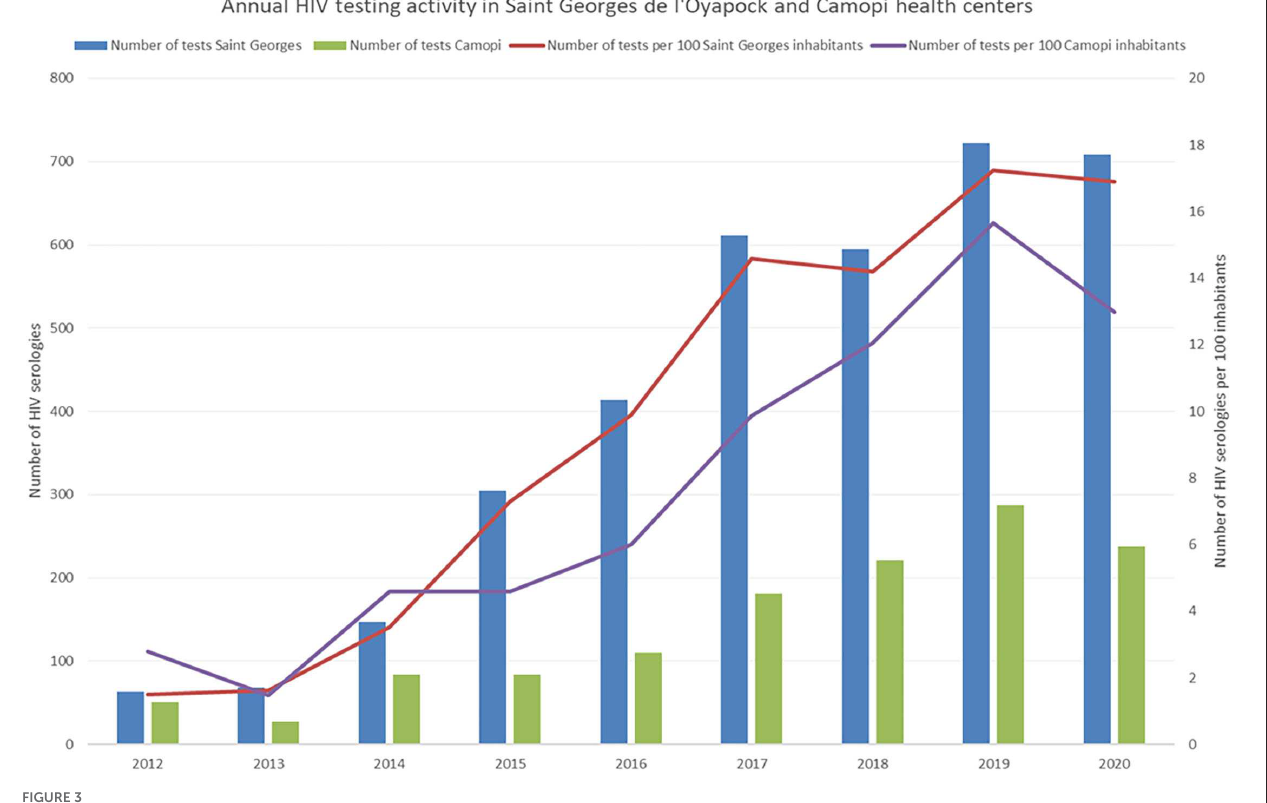
FIGURE3 Evolution of the HIV testing activity on the French side of the